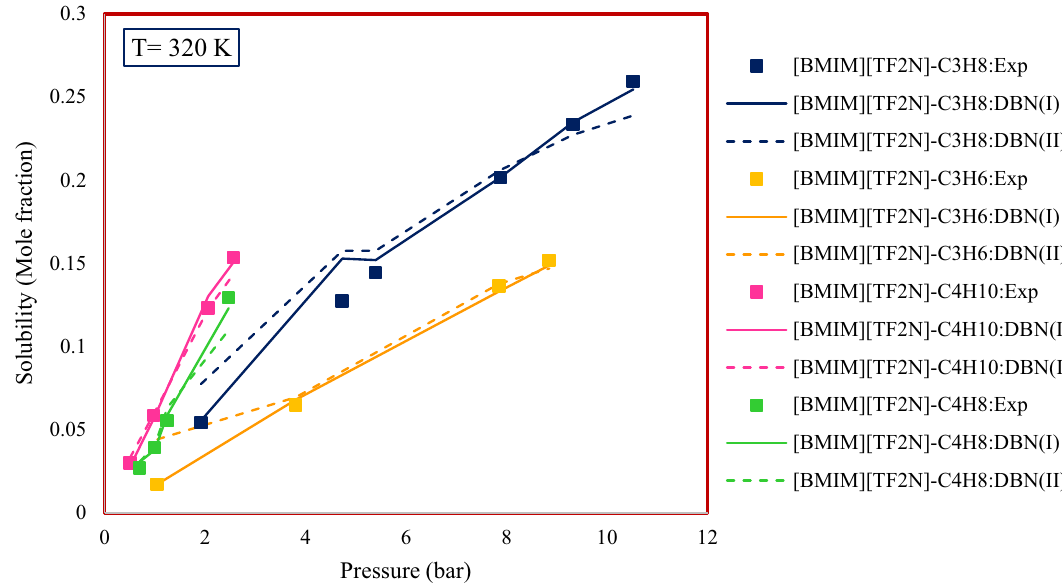
Figure 18. Type of hydrocarbon effect on the solubility of gaseous hydrocarbons n ionic